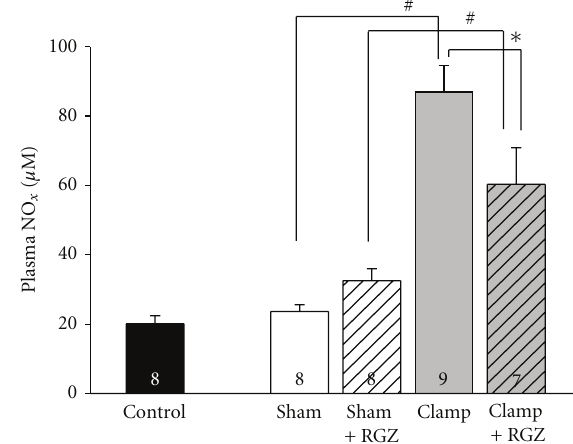
Figure 4: E ff ect of 5mg/kg rosiglitazone (RGZ) on nitrite/nitrate (NO x ) concentration in plasma of Sprague-Dawley rats in renal I/R injury. NO x as a measure of NO was detected by Griess-reaction as described in Section 2. NO x concentration is given in μ M. n is given in the respective bars. ∗ , # Indicate statistically significant di ff erence with P < 0 .